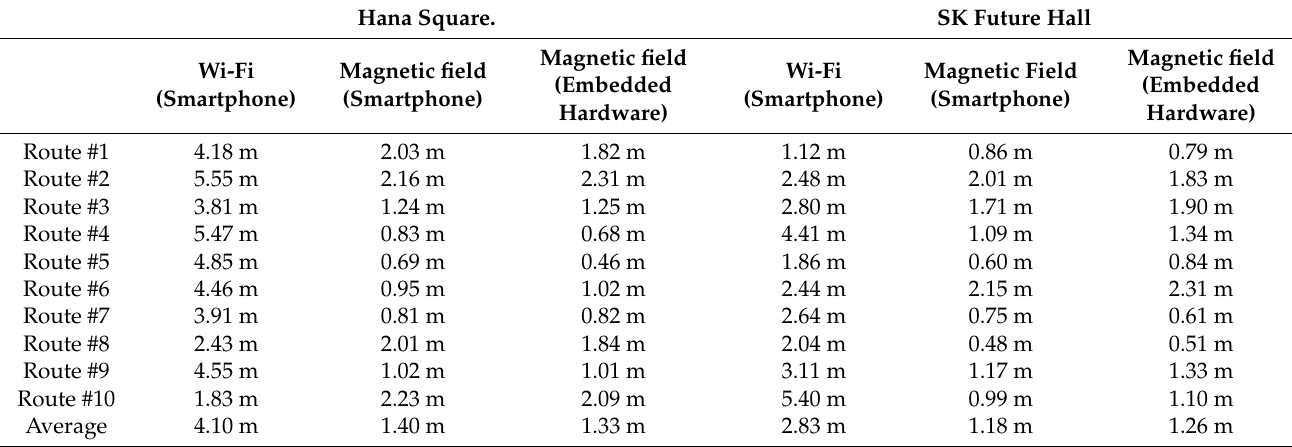
Table 4. Indoor localization errors based on the embedded hardware and the smart devices. Hana